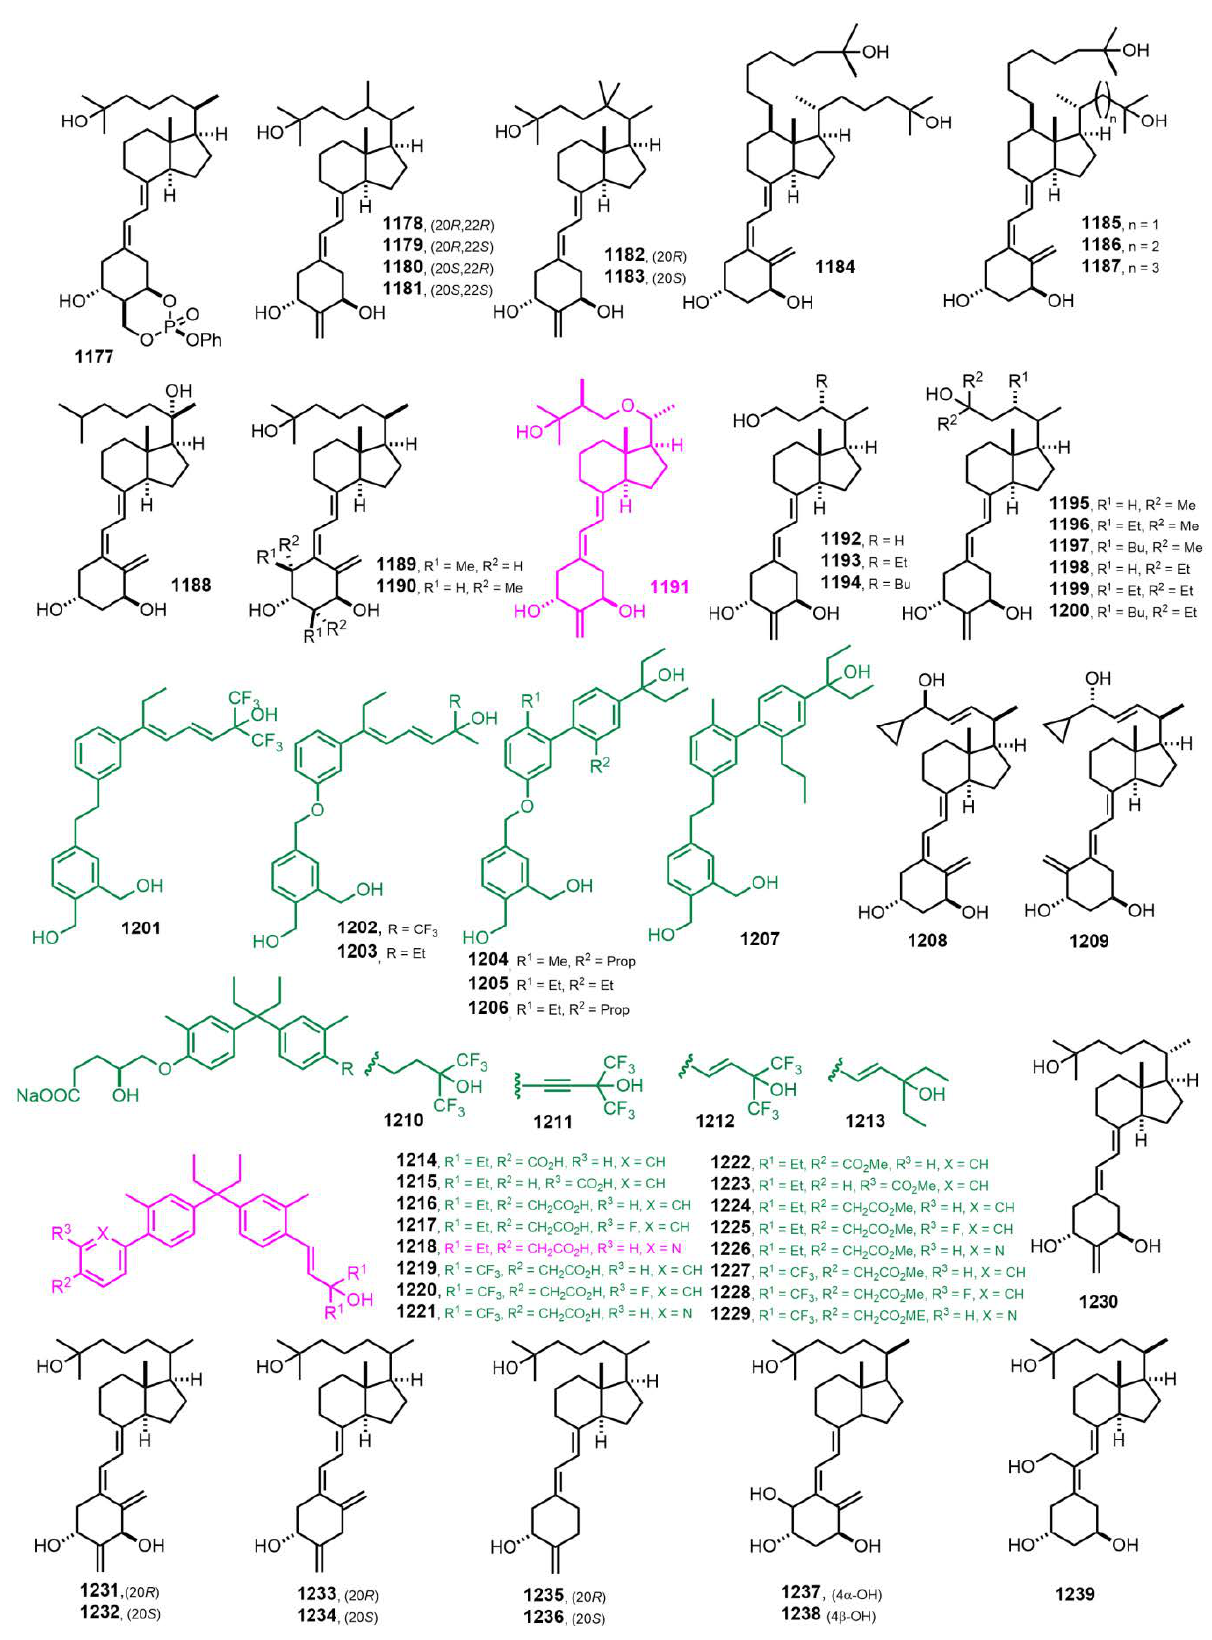
Figure 21. (2012-2013) [298 – 313].